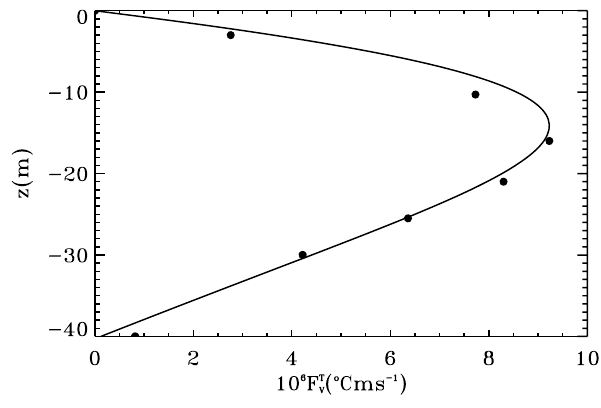
Fig. 2. Profile of the vertical heat flux F T lation data by Capet et al. (2008) (dots) obtained by integrating the dashed curve in Fig. 1, and for the present model (Eq. 12c) (solid curve).